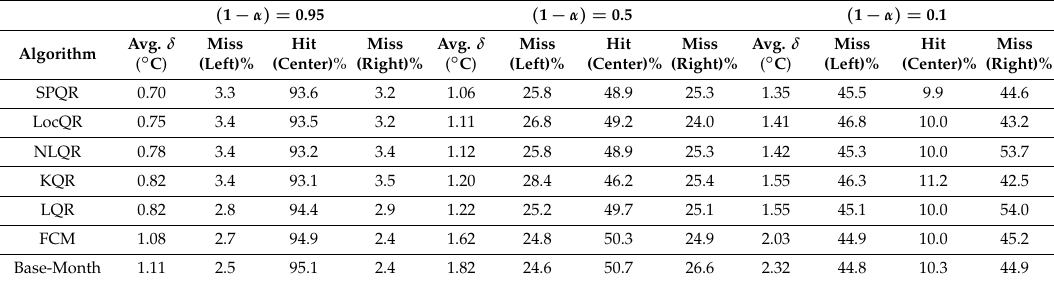
Figure 10. Comparison of SScore 0.95 between various methods over confidence levels. Table 3. Detailed coverage and miss ratio observations in test for three confidence